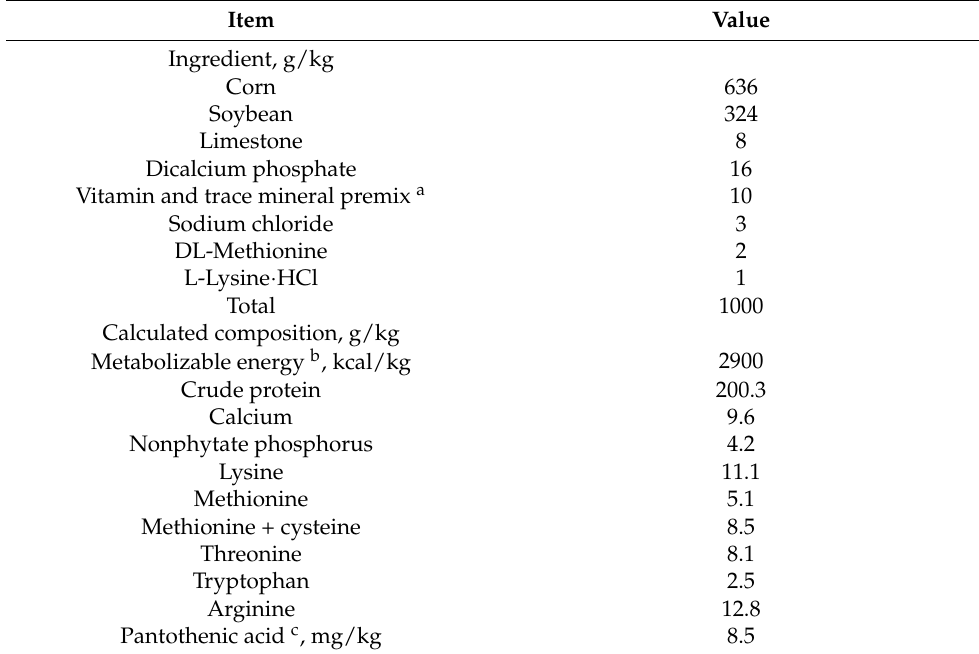
Table 1. Composition of the pantothenic acid-deficient basal diet from hatch to 21 days of age (g/kg as-fed). Item